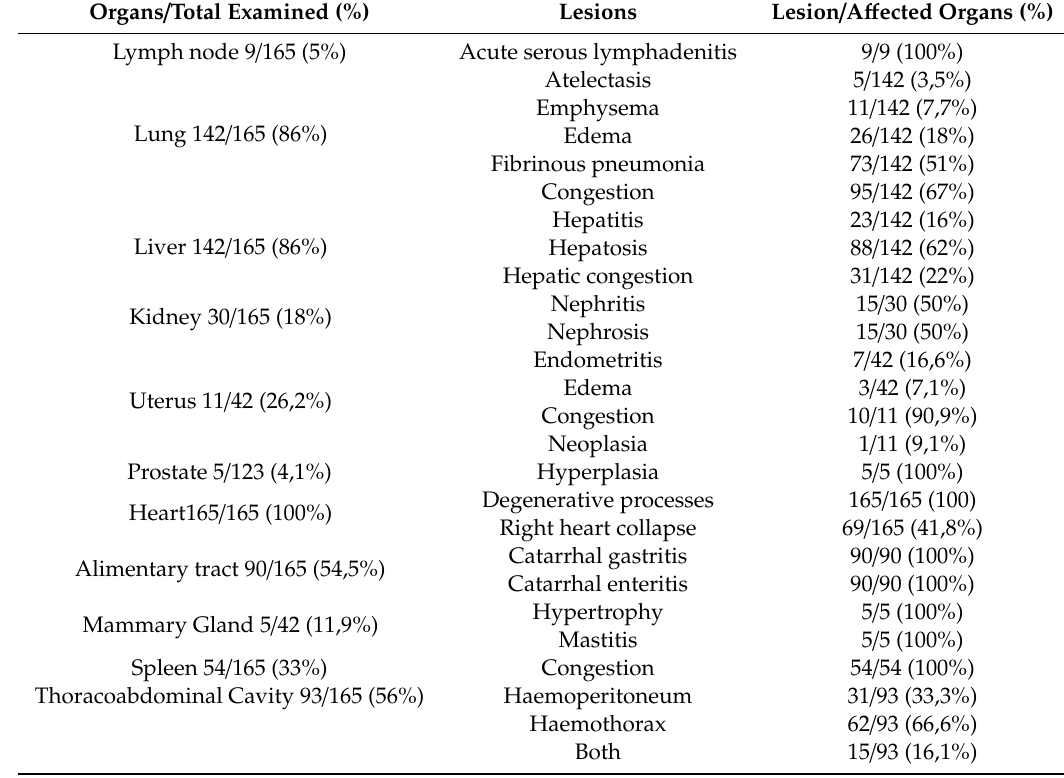
Table 1. Percentage of the lesion